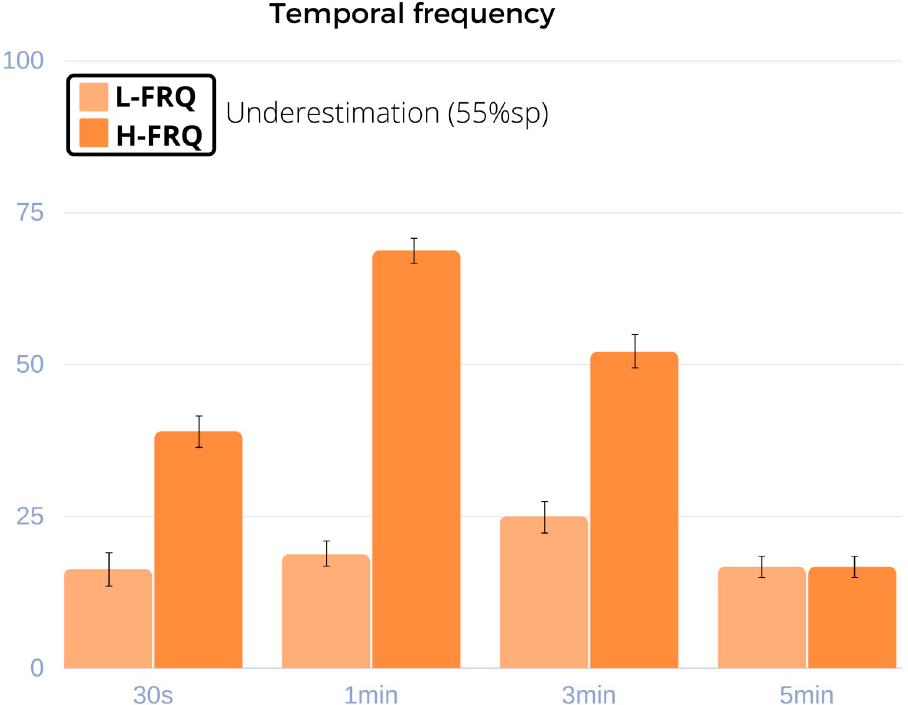
Fig 5. Results for Experiment 2. Y axis: % of answers. X axis: Temporal duration of the trials (30s, 1min, 3min, 5min). The displayed bars correspond to p under,55 at the 55% sp (underestimation). The percentage of correct answers for each case is complementary to the displayed value in the graph (p corr,55 +p under,55 = 100%). Like in Experiment 1, underestimation is more frequent in high magnitude levels, in this case in trials with a duration of up to three